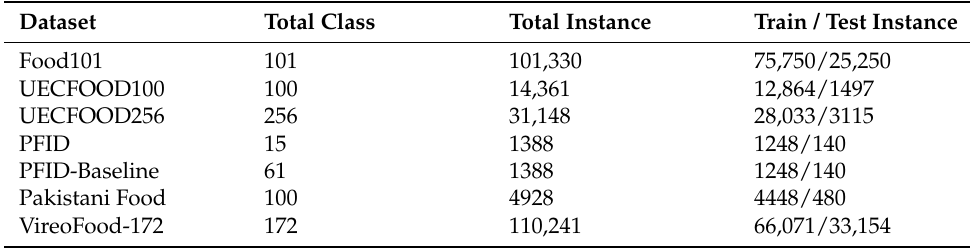
Table 2. Attributes of food datasets for food category classification.